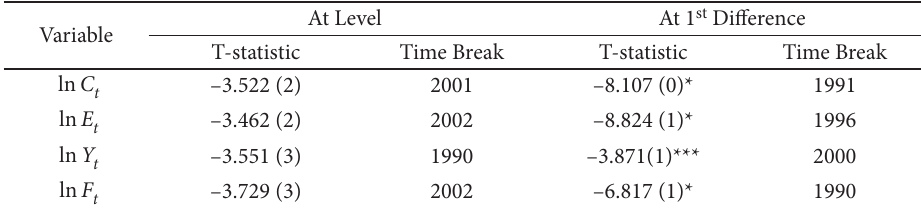
Table 2. Zivot-Andrews structural break trended unit root test Variable